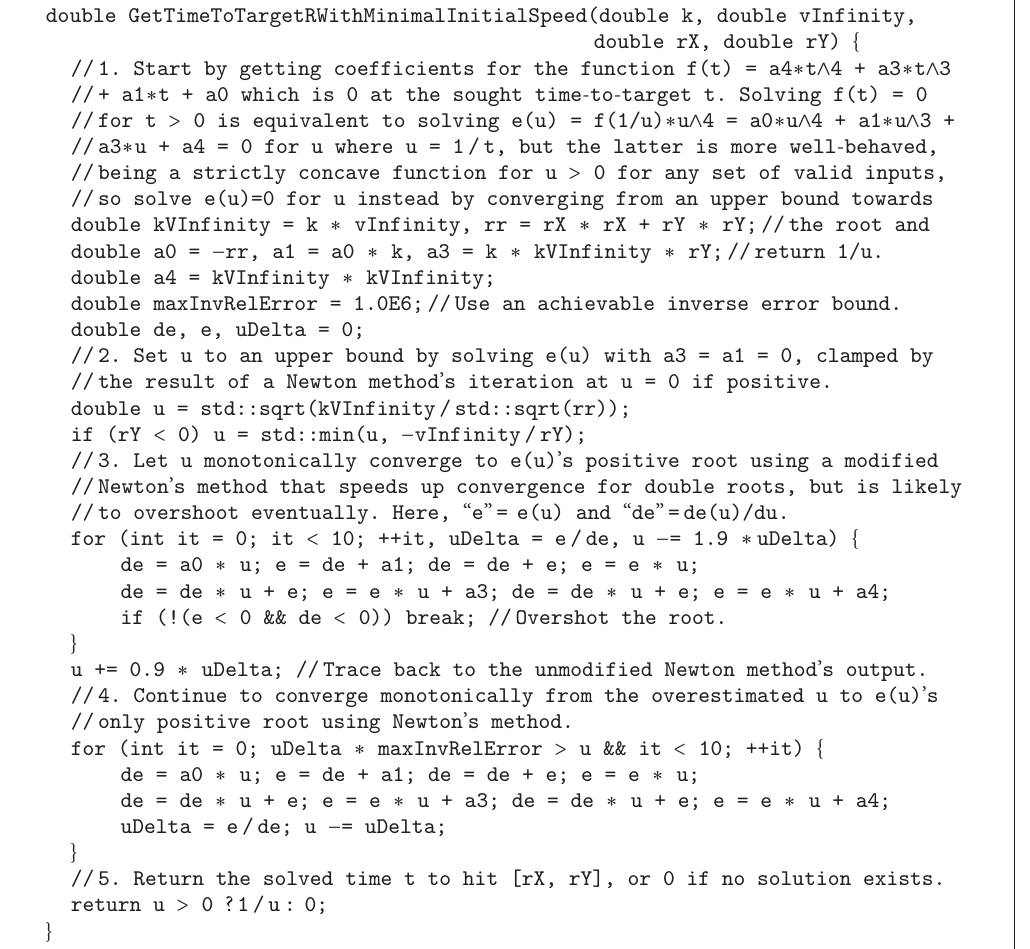
Algorithm 1: Specialized C++ Quartic